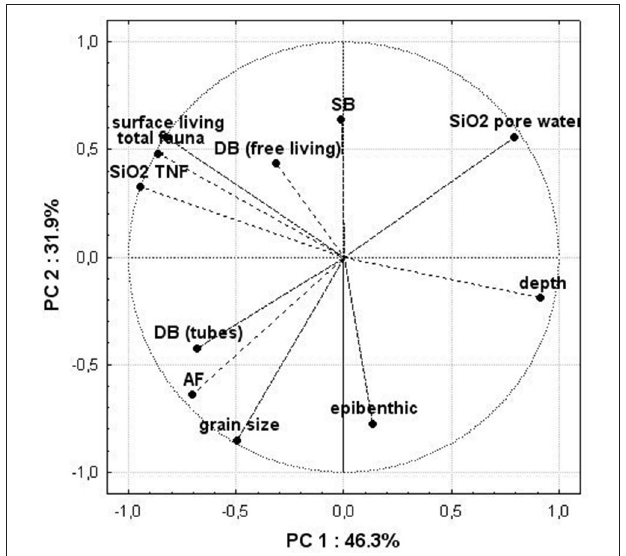
FIGURE 8 | Results of the principle component analysis (PCA). The eigenvectors of the correlation matrix are shown as lines. The variables included in the PCA are DB, deep burrowing fauna; SB, shallow burrowing fauna; epibenthic, epibenthic fauna; depth, water depth at the stations; total fauna, total amount of individuals of all groups at the station.